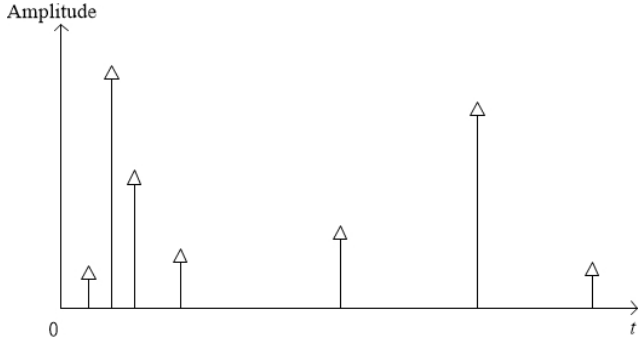
Figure 2. The illustration of the received signal intensity for a given element in uniform planar